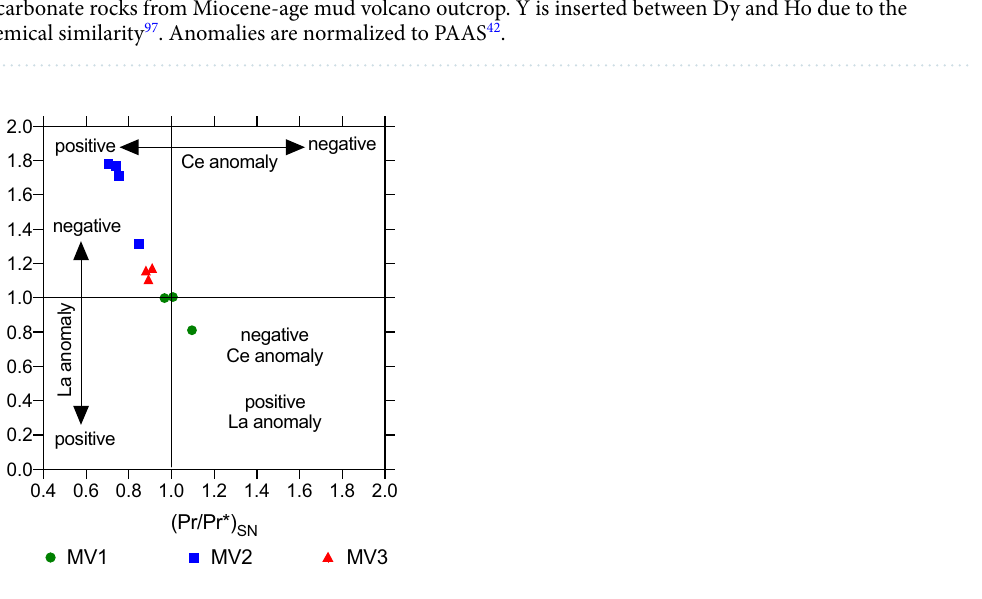
Figure 13. Relation between Ce/Ce* and Pr/Pr*in the Miocene mud volcano carbonates. MV2 shows the highest positive Ce anomaly while MV3 spots cluster at less intensive positive Ce. Two of MV1 spots show no anomalies and one indicate a negative Ce and positive La anomalies. This approach was described by (Bau and